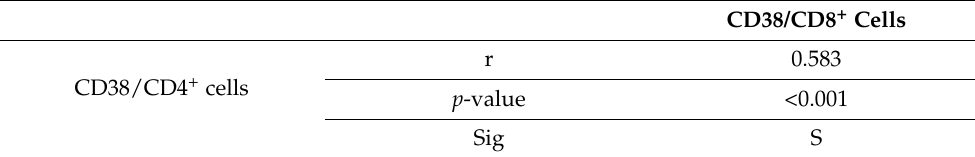
Figure 5 . Scatter diagram showing the correlation between CD38 expression in Th CD4 + T cell and Tc CD8 + T cell subtypes. Table 7. Correlation between CD38 expression in Th CD4 + T cell and Tc CD8 + T cell subtypes.